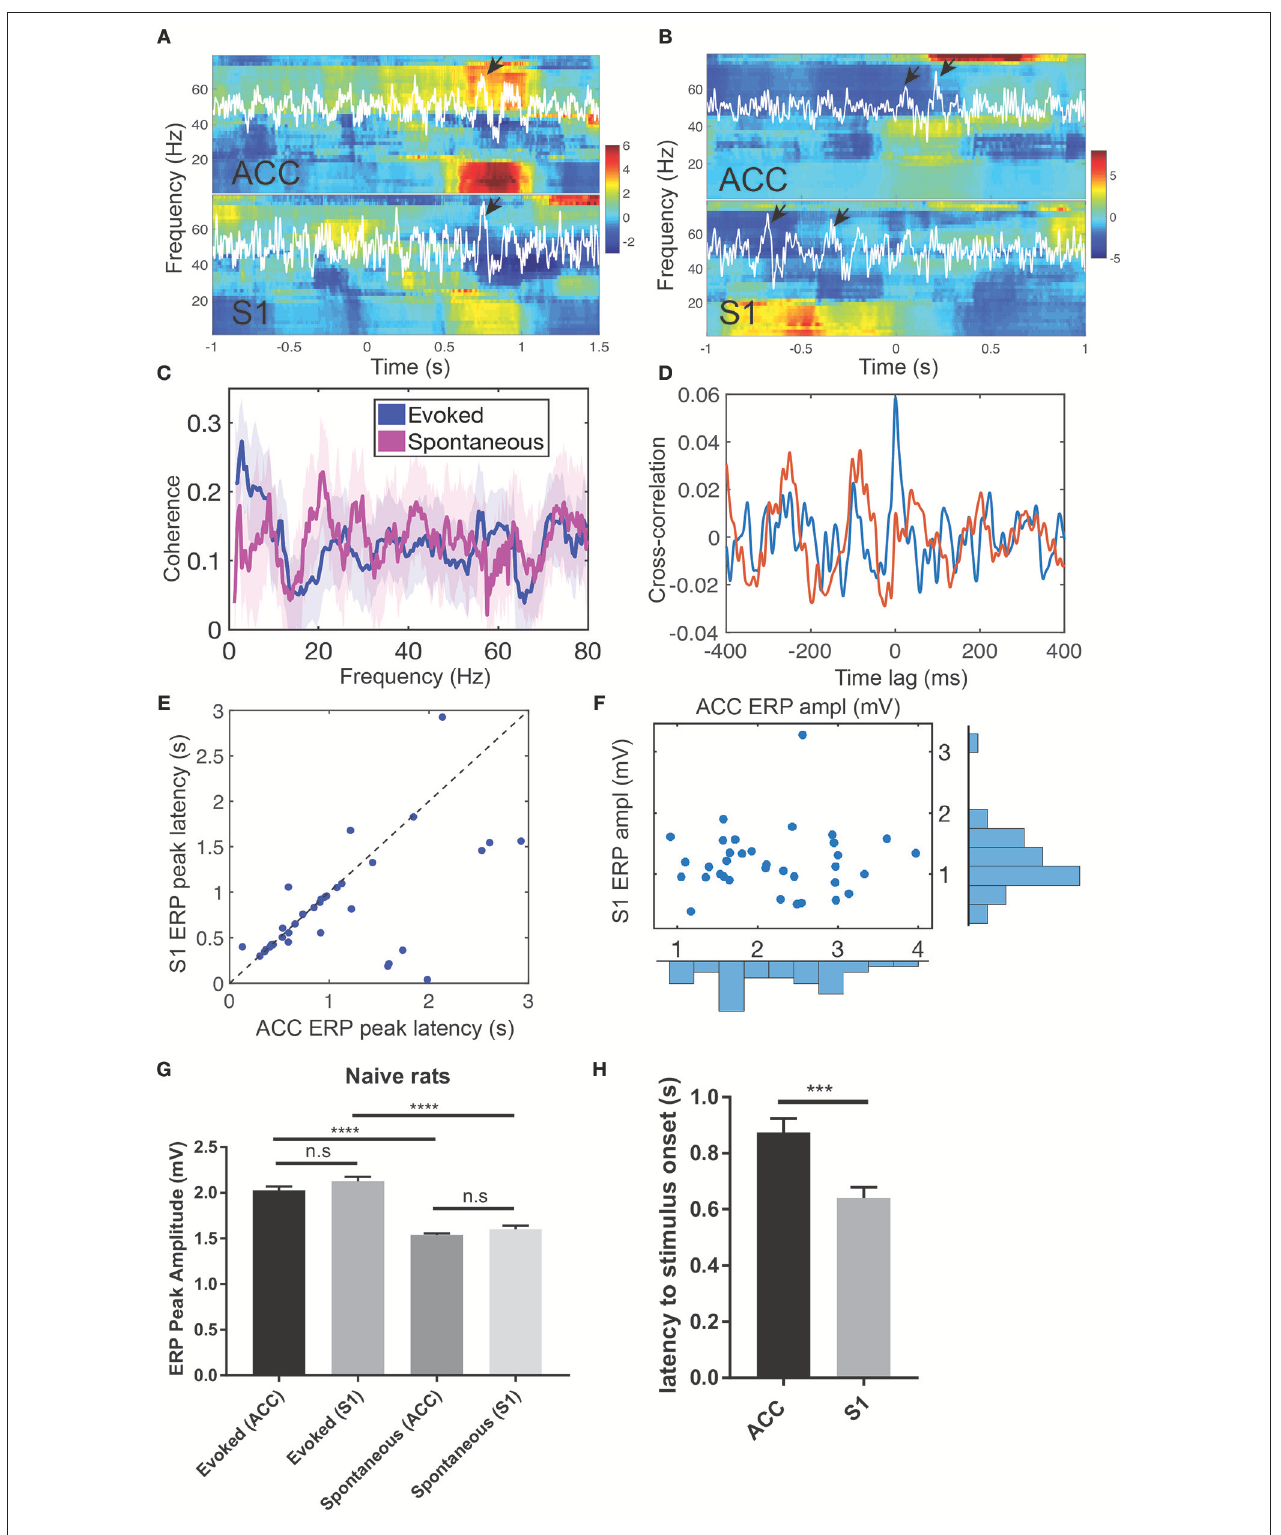
FIGURE 2 | Pain-induced ERPs of the rat ACC and S1. (A) Simultaneous recordings of LFPs from the ACC and S1 induced by evoked pain and their Z-scored spectrograms. White LFP traces were the dominant principal component extracted from multi-channel LFP signals. Arrows indicate the identified ERPs. Time